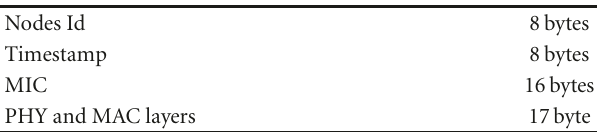
Figure 3: Minimum precision of BAN time versus sampling period. Table 2: SPS packet